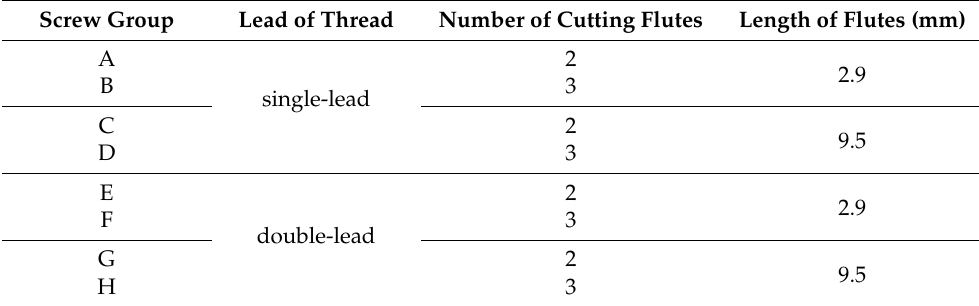
Table 1. Design features of eight pedicle screws evaluated in this study. Screw